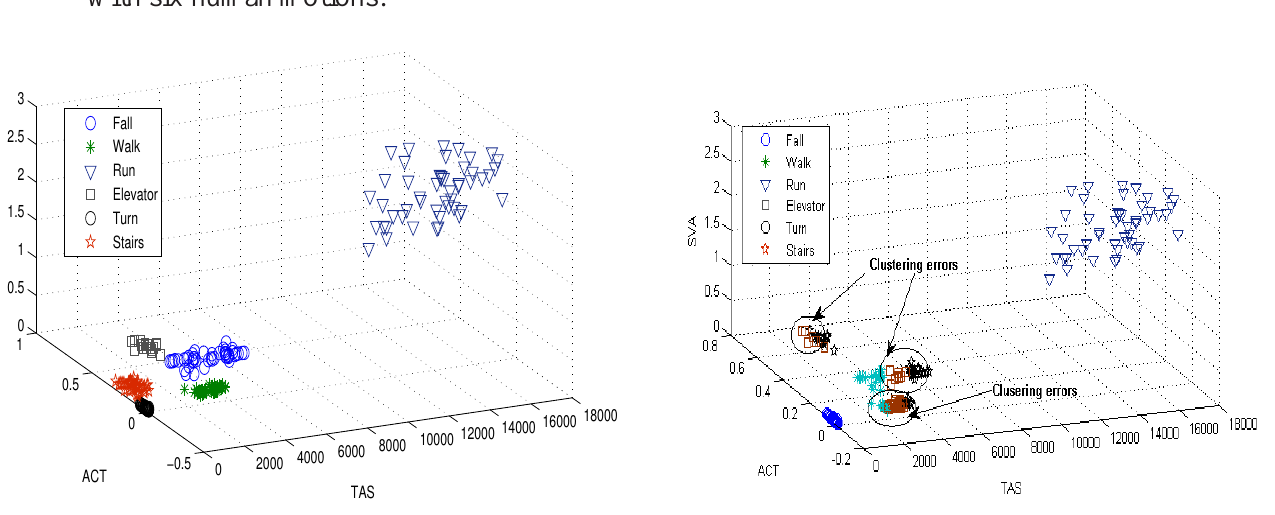
Figure 8. Clustered results for the proposed algorithm ( left ) and the K-Means method ( right ) with six human